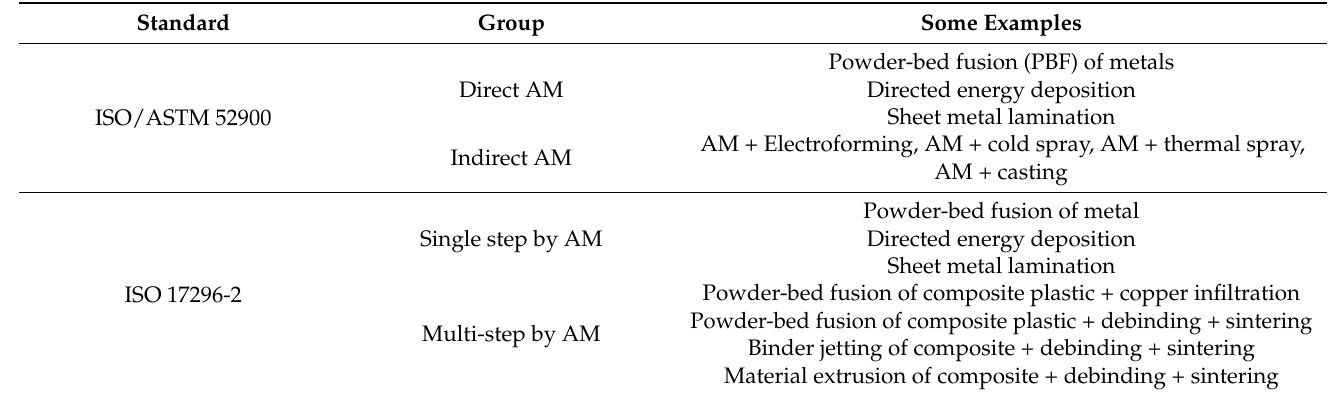
Table 1. Examples of potential procedures to produce EDM electrodes by